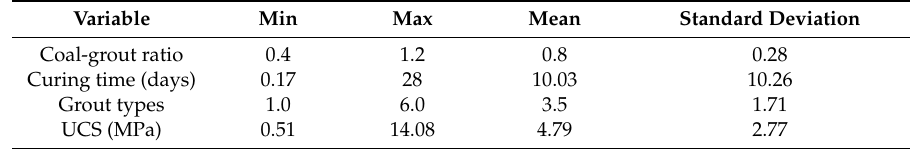
Table 3. Statistics of